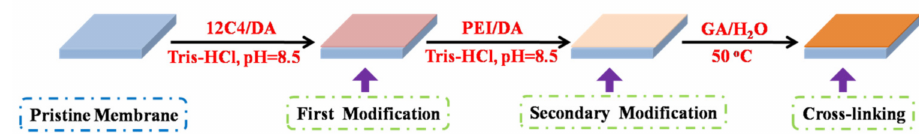
Figure 1. Schematic illustrations of the modified processes on SPSF membrane